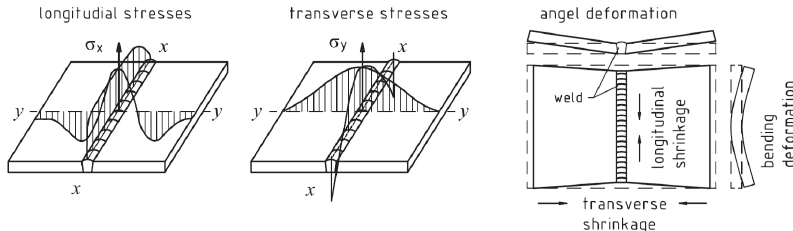
Fig. 1. Structural and geometrical imperfections after welding (Radaj 1998)